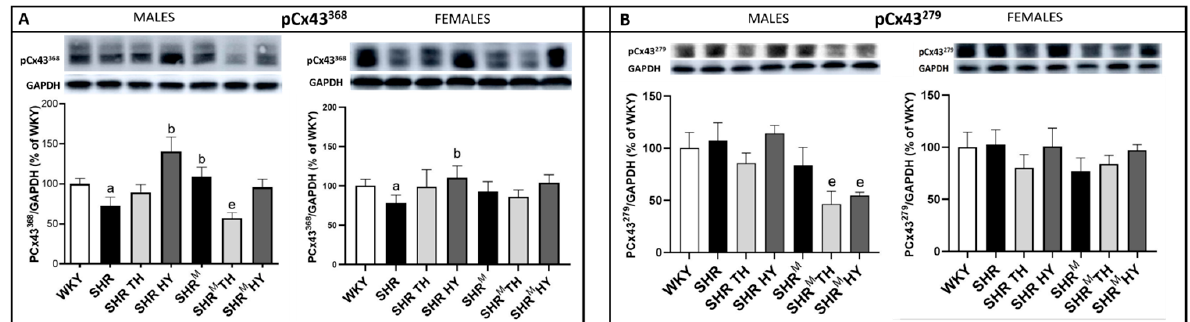
Figure 6. Protein levels of Cx43 variants pCx43 368 ( A ) and pCx43 279 ( B ) assessed by the Western blot analysis. Note the reduced levels of pCx43 368 in wild type SHR males compared to WKY but not in hairless SHR M males. WKY—Wistar Kyoto normotensive control rats, SHR—wild type spontaneously hypertensive rats, TH—hyperthyroid rats, HY—hypothyroid rats and SHR M — hairless spontaneously hypertensive rats, n = 5 in each group. Data are presented as means ± SD, a p < 0.05 vs. WKY, b p < 0.05 vs. SHR and e p < 0.05 vs. SHR M . One-way ANOVA and Bonferroni’s multiple comparison test were used as the statistical method.